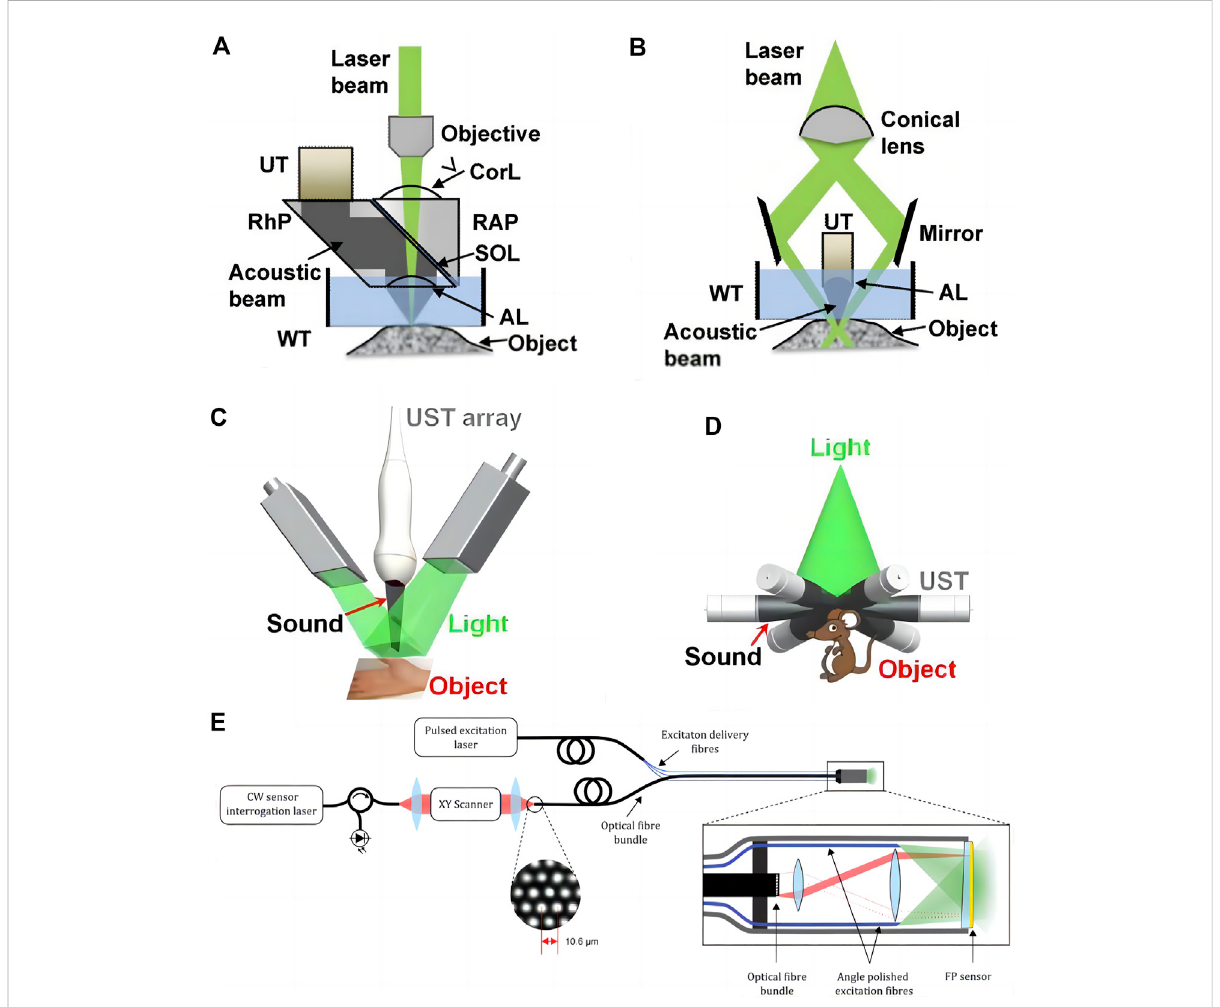
FIGURE 1 Major embodiments of photoacoustic imaging. (A) Second-generation optical-resolution photoacoustic microscopy (G2-OR-PAM). (B) Dark- fi eld acoustic-resolution photoacoustic microscopy (AR-PAM). AL, acoustic lens; Corl, correction lens; RAP, right angled prism; RhP, rhomboid prism; SOL, silicone oil layer; UT, ultrasonic transducer; WT, water tank [reproduced from (Yao and Wang., 2013) with permission from John Wiley and Sons]. (C) Linear-array PACT. (D) Circular-array PACT [reproduced from (Wang and Hu., 2012) with permission from The American Association for the Advancement of Science]. (E) Schematic of the fl exible all-optical, forward-viewing PA endoscopy probe [reproduced from (Ansari et al., 2020) with permission from The Optical